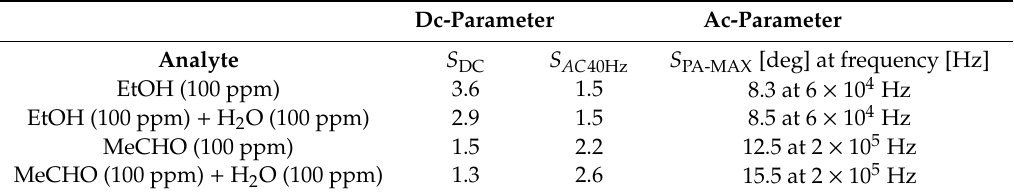
Figure 10. The dependence of phase-angle response vs. frequency for 100 ppm MeCHO ( a ); 100 ppm MeCHO + 100 ppm H 2 O ( b ). The reference atmosphere was synthetic air. Table 1. Detection parameters of ZnO-nanorod based chemiresistors: dc-response ( S DC ); ac-response at 40 Hz ( S AC 40Hz ); maximum phase-angle response S PA-MAX and the corresponding frequency of the measuring signal. The reference atmosphere was synthetic air in all cases.